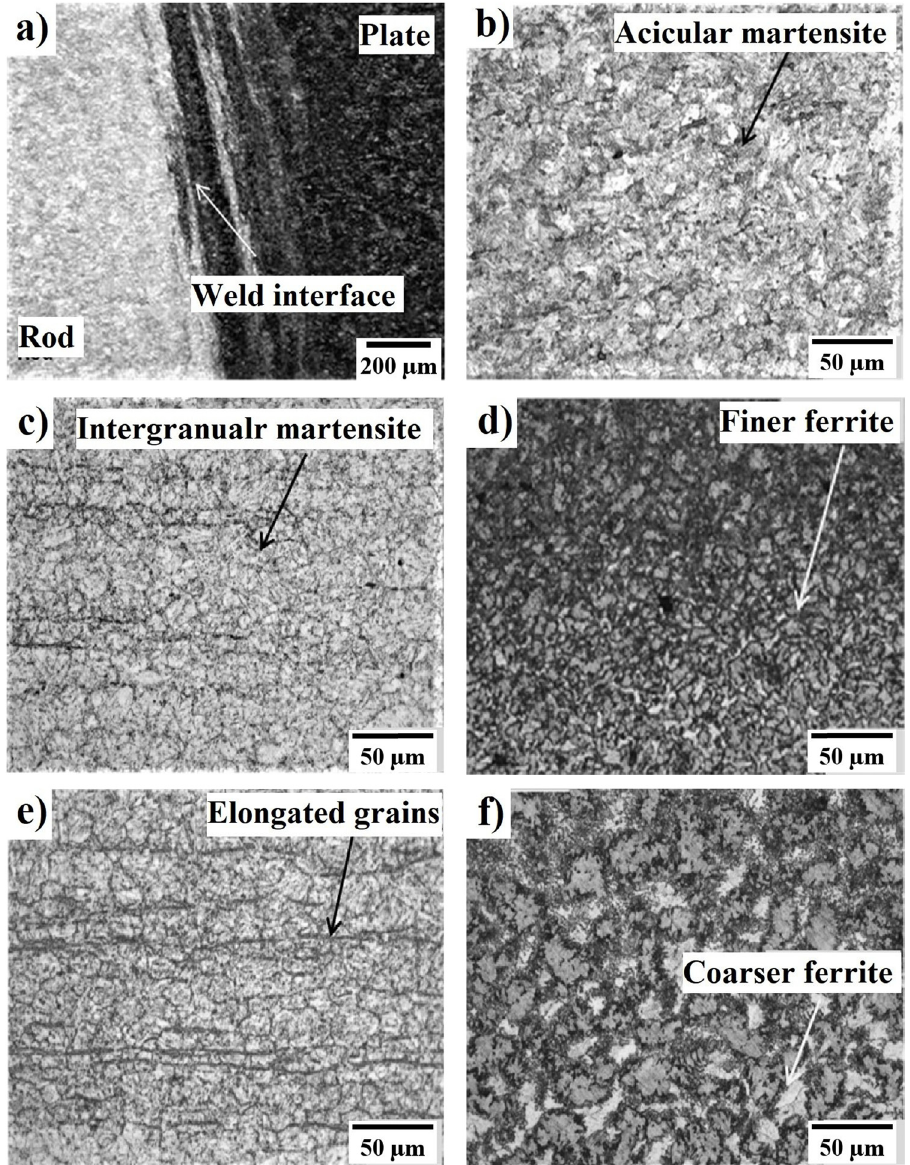
Figure 11: Optical microstructures of di ff erent regions of rod - to - plate joint: ( a ) weld interface, ( b ) FDZ, ( c ) PDZ of AISI 431 steel rod, ( d ) PDZ of